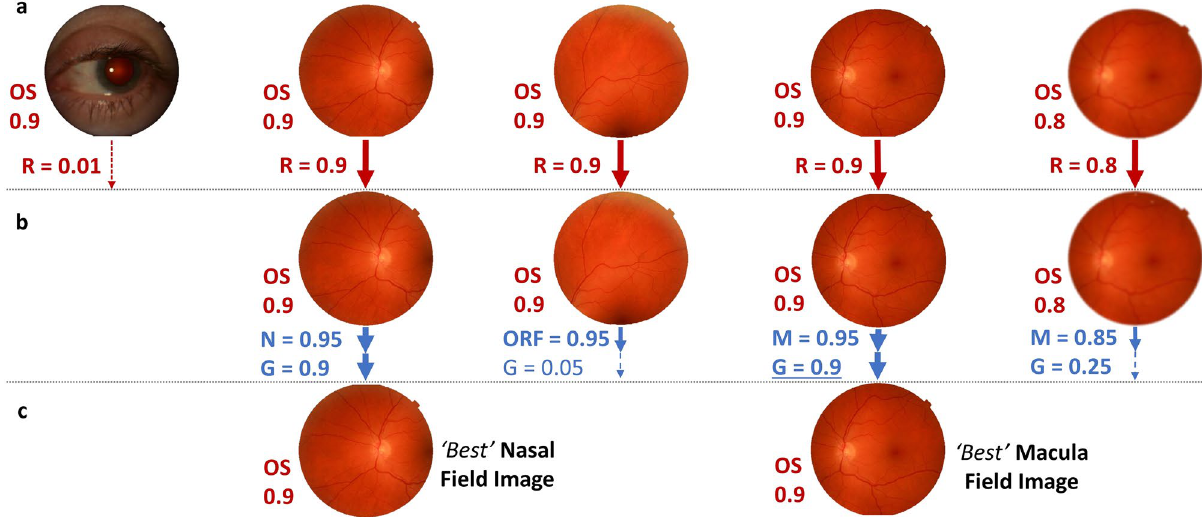
Figure 6. Proposed curation workflow. ( a ) Images get predictions for laterality and retinal presence ( values indicate model predictions between 0 and 1 ) allowing for the exclusion of non-retinal images ( e.g., anterior segment ). ( b ) Images obtain retinal field and gradability predictions which allows for the exclusion of other retinal field images and for the selection of gradable images from macula or nasal fields by selecting the image with the highest gradable score ( underlined ). ( c ) The ‘best’ macula and nasal field with an identifiable laterality are then selected; these gradable, 2-field images are then suitable for subsequent manual or automated diabetic retinopathy grading. R: Retinal presence, OS: Left eye, N: Nasal, M: Macula, ORF: Other retinal field, G: